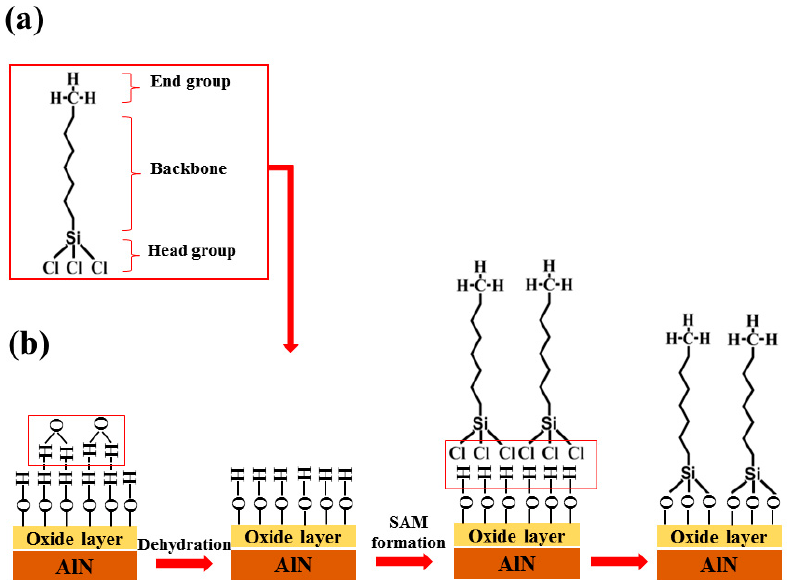
Figure 1. ( a ) Schematic of octyltrichlorosilane molecule indicating the headgroup, backbone, and end group. ( b ) Schematic of obtaining siloxane protective layer on AlN powder.